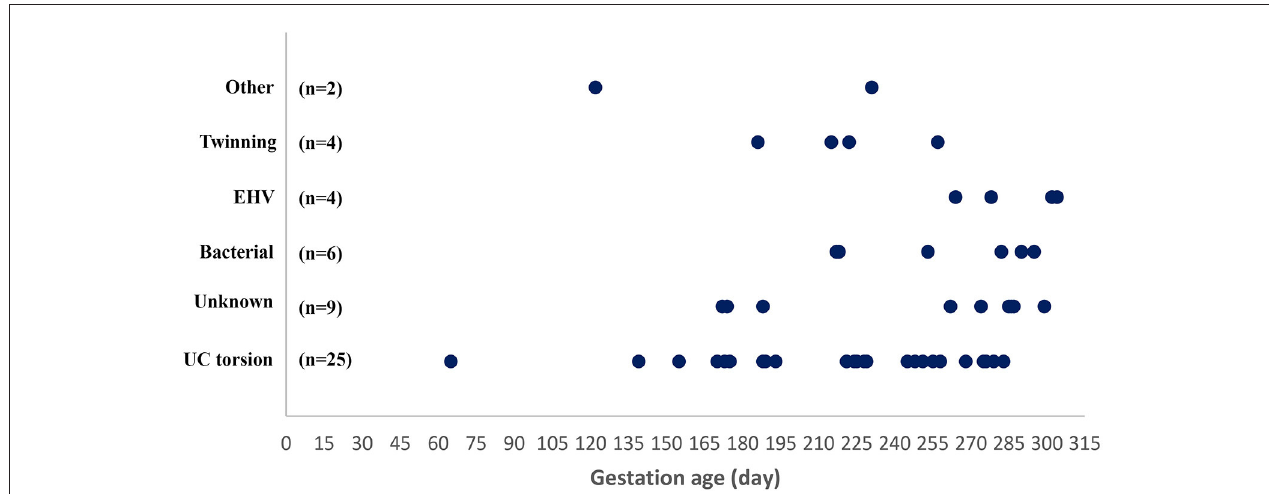
FIGURE 1 | Gestational age at abortion or premature stillbirth in 50 mares grouped according to cause of pregnancy loss. UC torsion, umbilical cord torsion or other cord anomaly; EHV-1, equid alphaherpesvirus type 1.